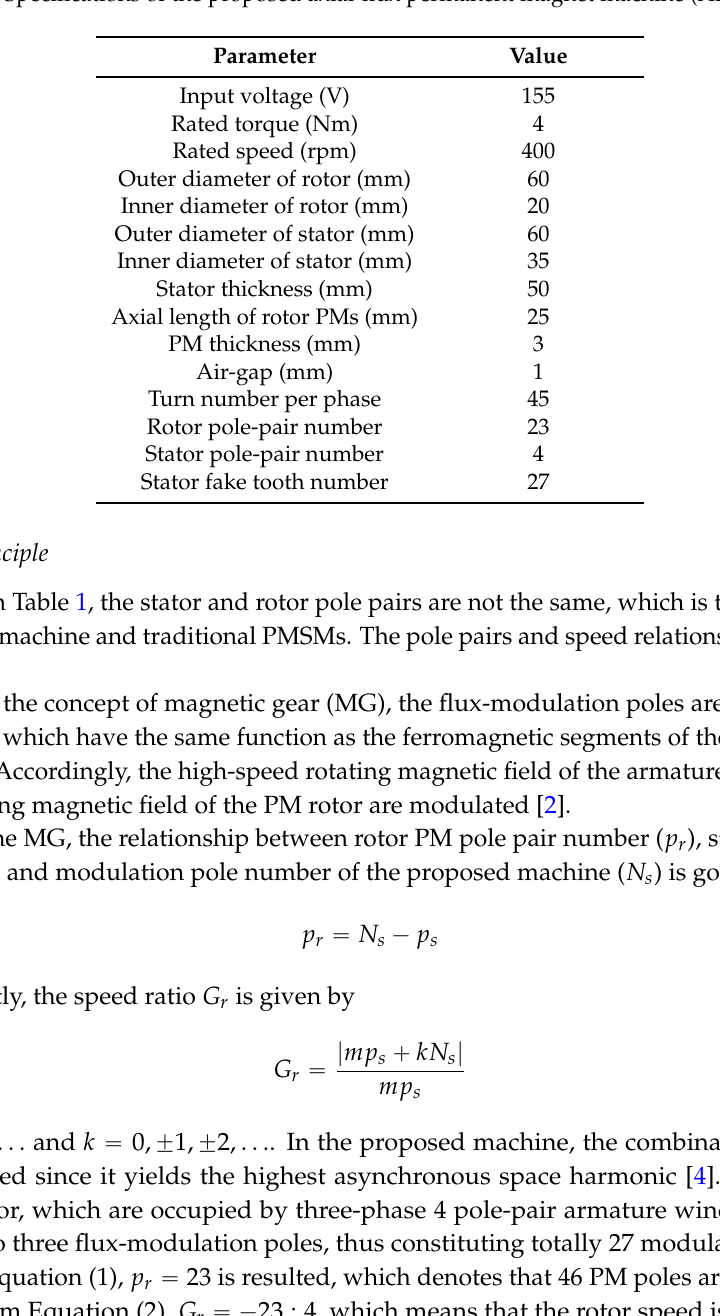
Table 1. Specifications of the proposed axial-flux permanent magnet machine